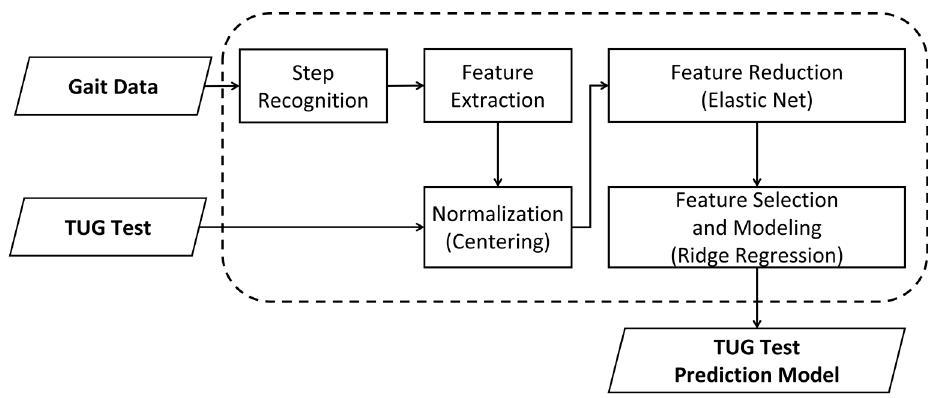
Figure 1. Framework for developing the timed up and go (TUG) test prediction model.